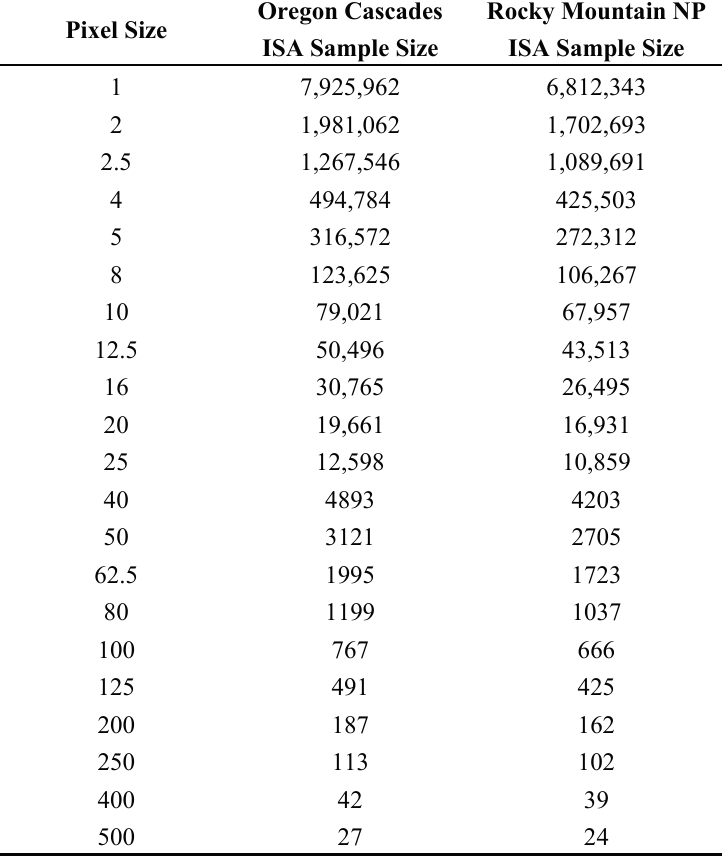
Table 3. Pixel sizes used to compute frequency of mixed pixels and corresponding pixel sample sizes for each